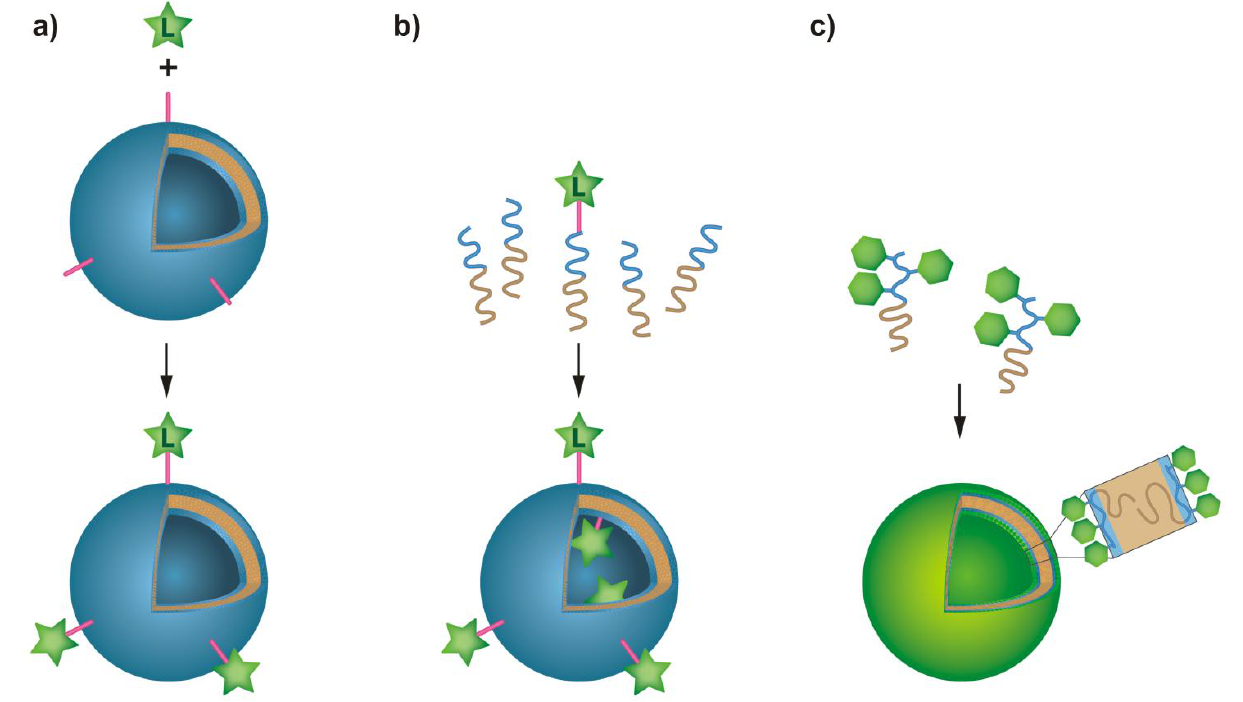
Figure 1. Routes to functional block copolymer vesicle surfaces. ( a ) Conjugation of a functional entity to preformed vesicles. ( b-c ) Self-assembly of functionalized and non-functionalized amphiphilic block into functionalized block copolymers, and ( c ) block copolymers having a functional